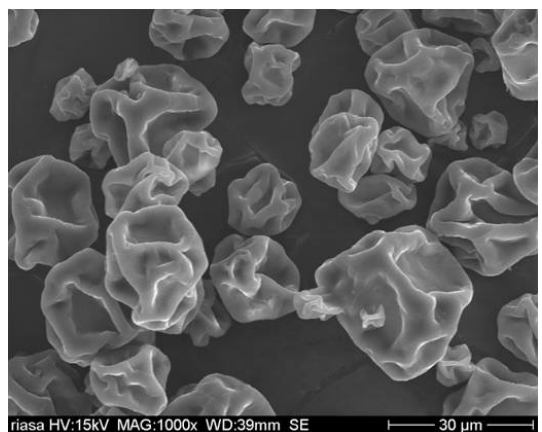
Figure 5. SEM image of apenueted culture of Chlorella kessleri at